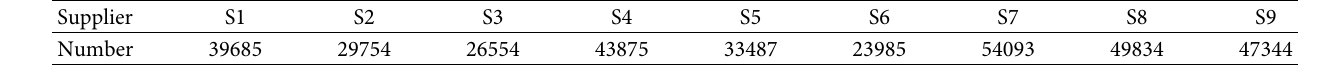
Table 3: The number of purchases from each supplier.